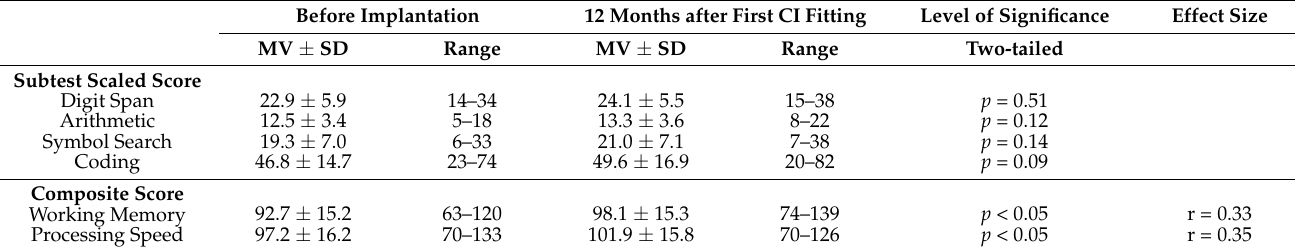
Table 2. Scores of the WAIS-IV subscales and composite IQ scales before implantation and 12 months after the CI fitting. The level of significance indicates the difference between the examination points. The results are shown as MV ± SD. The effect size is defined as a quotient of the Z-score of the Wilcoxon test and the square root of the number of total subjects [62]. Before Implantation 12 Months after First CI Fitting Level of Significance Effect Size Range